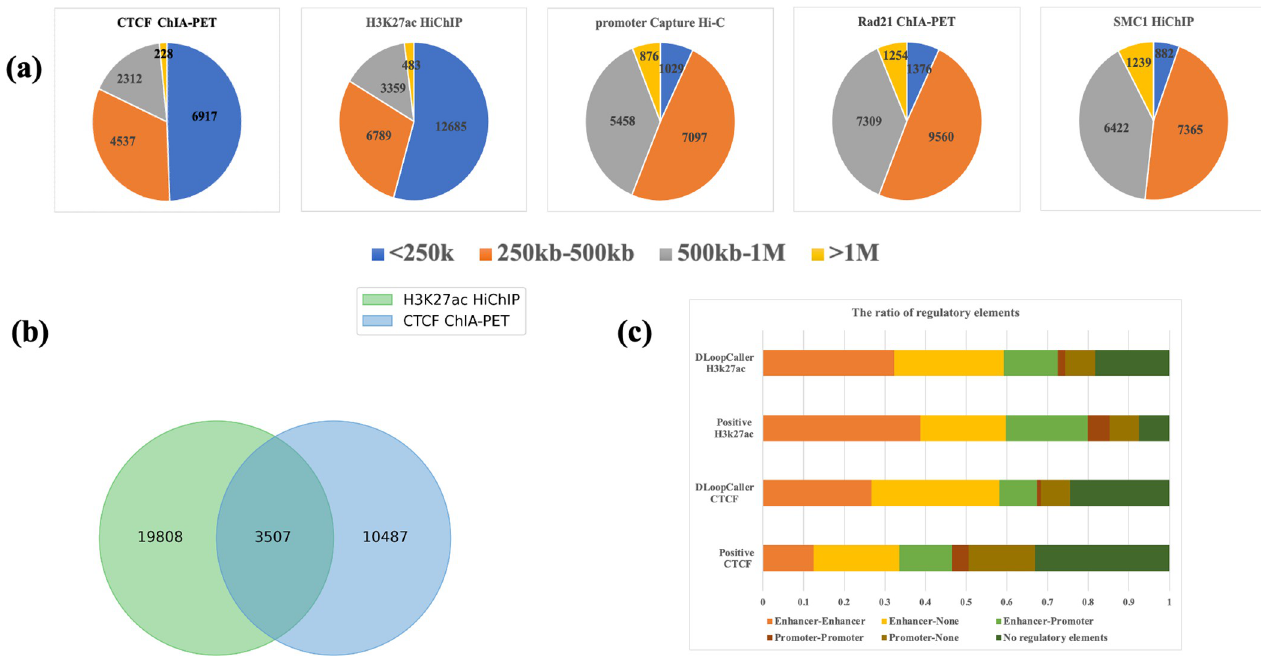
Fig 4. Comparison of chromatin loops within individual cell types. (a) Distance distribution of DLoopCaller identified chromatin loops from Hi-C contact maps by using CTCF ChIA-PET, H3K27ac HiChIP, SMC1 HiChIP, RAD ChIA-PET, and promoter Capture Hi-C data after training on GM12878. (b) Venn diagram of DLoopCaller identified chromatin loops determined by CTCF ChIA-PET and H3K27ac HiChIP experiments in GM12878. (c) The proportion of CTCF ChIA-PET interactions and H3K27ac HiChIP interactions types for GM12878. The proportion of identified chromatin loops types using CTCF ChIA-PET data and H3K27ac HiChIP after training for GM12878.